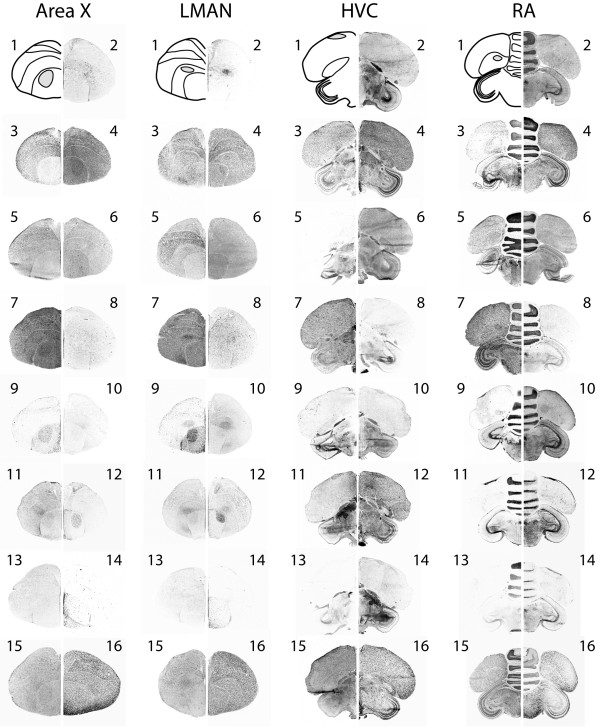
Distribution of genes in four major song nuclei. Results of in situ hybridization for 15 selected genes in four major telencephalic song nuclei: Area X, the lateral magnocellular nucleus of the anterior nidopallium (LMAN), HVC, and the robust nucleus of the arcopallium (RA), showing a complex distribution of expression across the song system. The approximate area of each nucleus is illustrated in the top left panel displaying results for each nucleus. Left and right hemispheres display different genes, all labelled with numbers as follows: 1-schematic; 2-NTS; 3-ADCYAP1; 4-VIP; 5-SCG1; 6-OREX; 7-MST; 8-POMC; 9-NPY; 10-CPN2; 11-CBLN1; 12-TAC1; 13-NPVF; 14-PENK; 15-PEBP1; 16-SST.